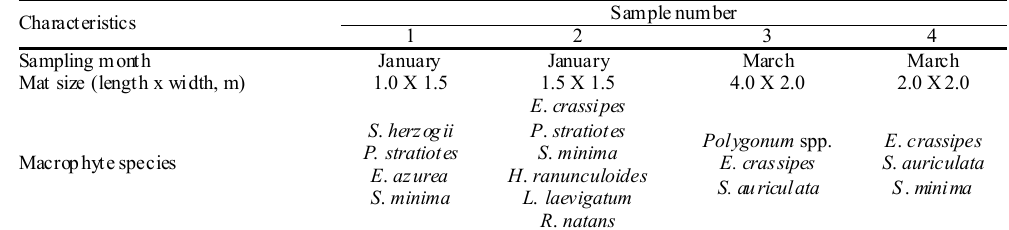
Table 1. Characteristics of the four floating macrophyte mats sampled while drifting on the Ivinhema River, Brazil, in January and March, 2005. The order of macrophyte species represents numerical